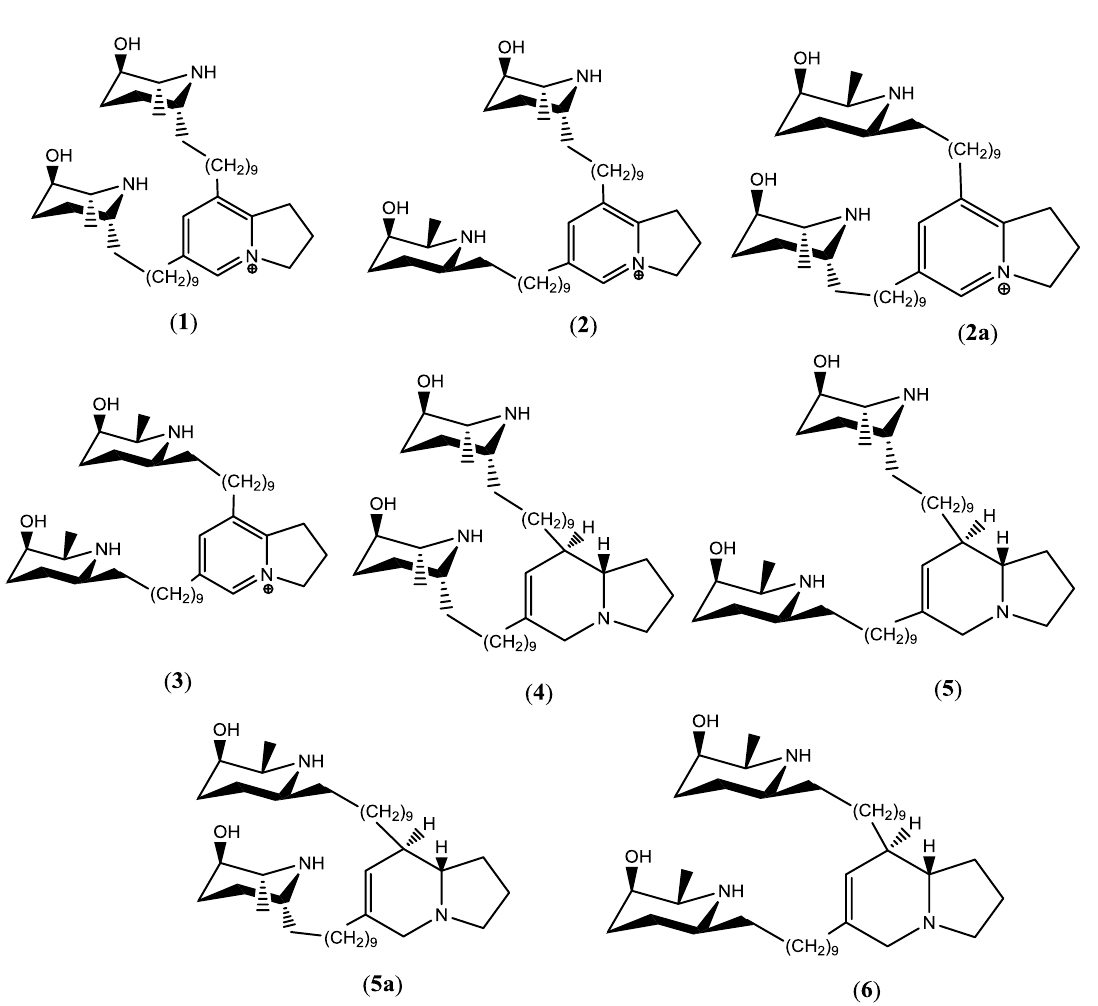
Figure 1. Chemical structures of indolizidine alkaloids isolated from P. glandulosa var. gladulosa : prosopilosidine ( 1 ), isoprosopilosidine ( 2 / 2a ), juliprosine ( 3 ), prosopilosine ( 4 ), isoprosopilosine ( 5 / 5a ), and juliprosopine ( 6 ).